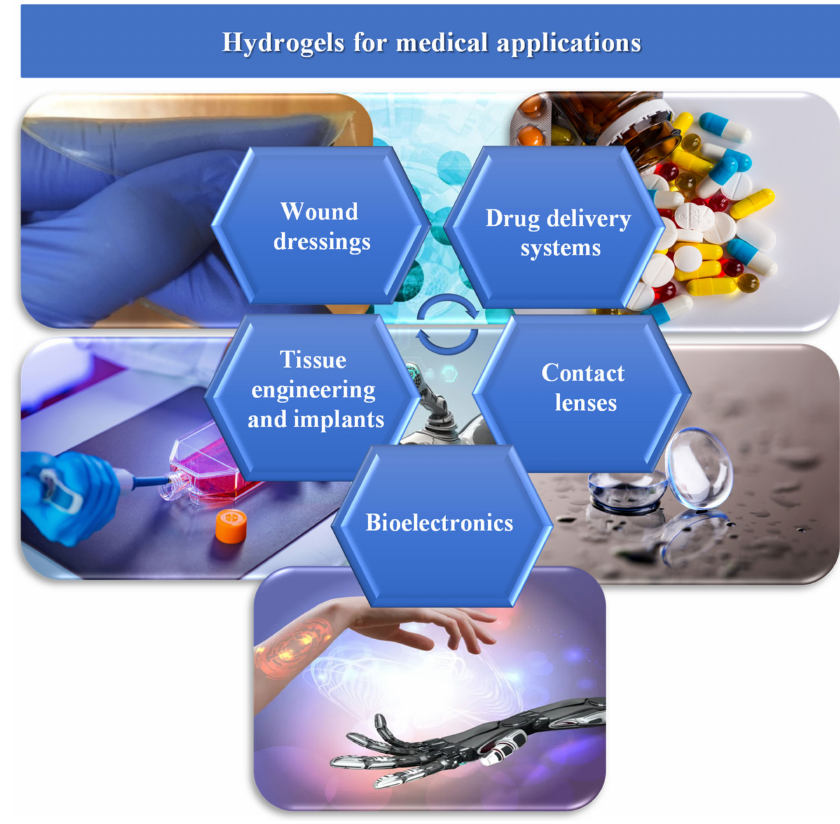
Figure 1. Hydrogels for medical